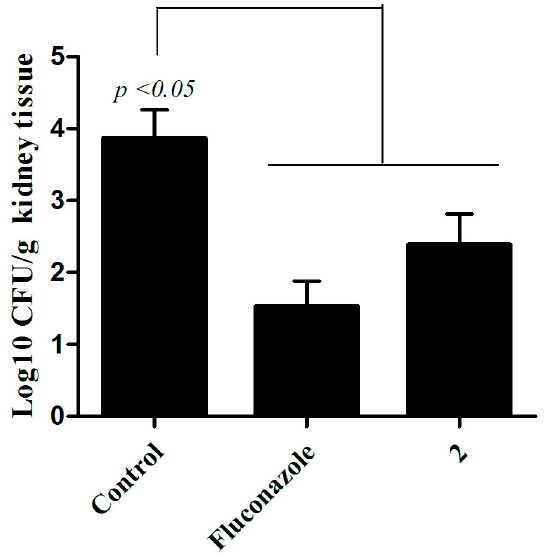
Figure 7. Murine model treatment of systemic candidiasis. The number of colony-forming units (CFU) recovered from the C. albicans CAN14-infected C57BL/6 female mice was lower in animals treated with fluconazole (10 mg/kg) and thiazolylhydrazone derivative 2 (10 mg/kg) than in the control group that received no treatment (Newman-Keuls Multiple Comparison test).